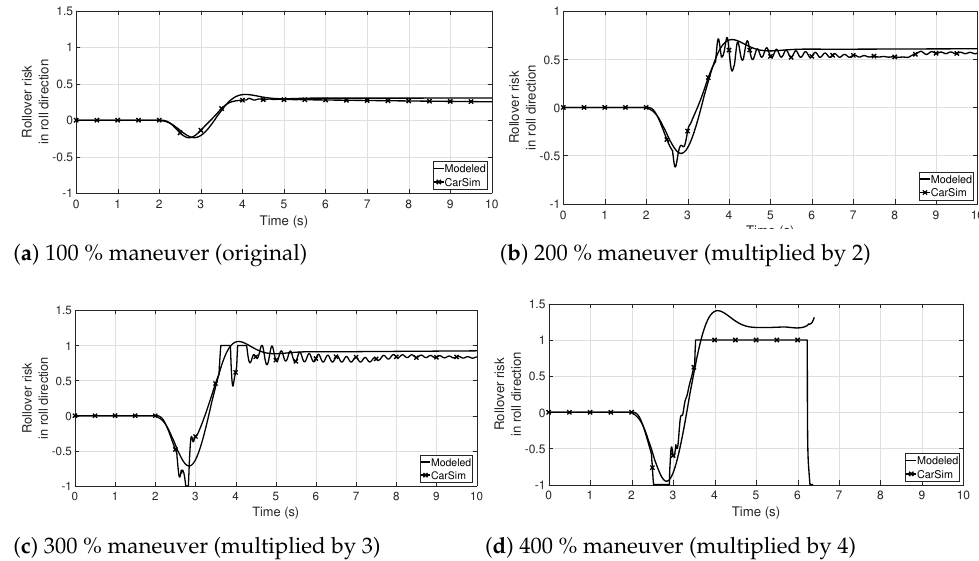
Figure 4. Comparison of the rollover risk in roll direction ( RI ϕ ) modeled in this paper, and calculated by the vertical forces provided by CarSim, using the maneuver of Figure 2a multiplied by 100, 200, 300, and 400%. The model presented in this paper is precise enough to detect an imminent rollover to the left or right side. With the 400% maneuver, the TWV rollovers to the left; from second 3.65 onwards, the rear right wheel is lifted off the